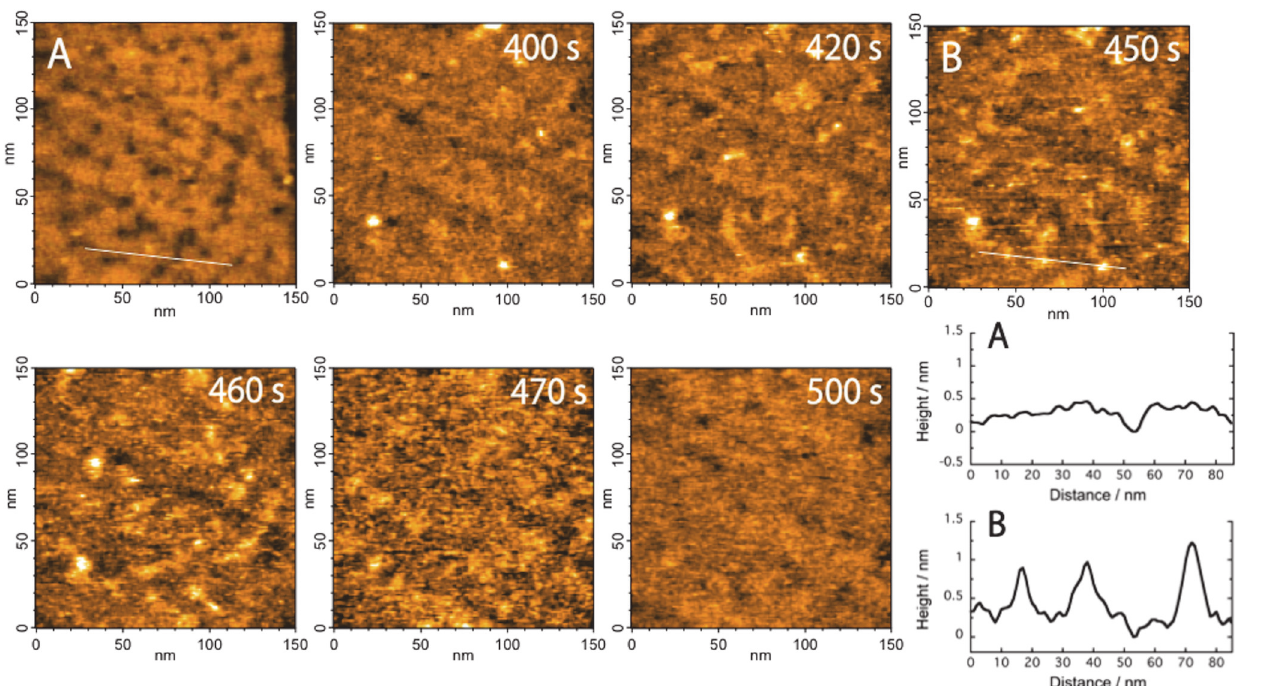
Figure 1. AFM images show (A) the MUA-modified gold surface and (B) cyt c adsorbed on the MUA SAM at 450 sec. Continuous AFM images of adsorbing cyt c molecules with real-time labels. Frame rate, 2 frames/s; image area, 150 × 150 nm 2 . The cross sections of the images in (A) and (B), along the short white line, are shown in the lower right.